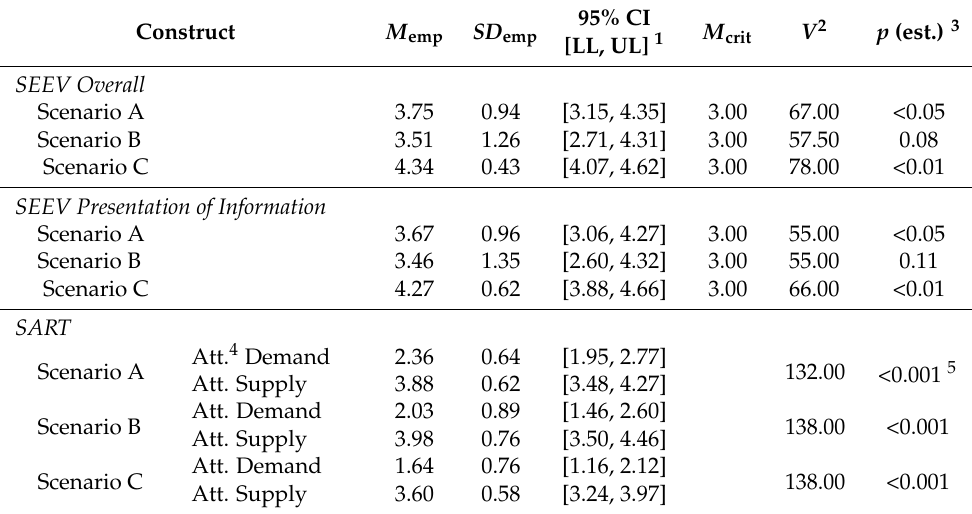
Table 9. Descriptive and inferential statistics regarding